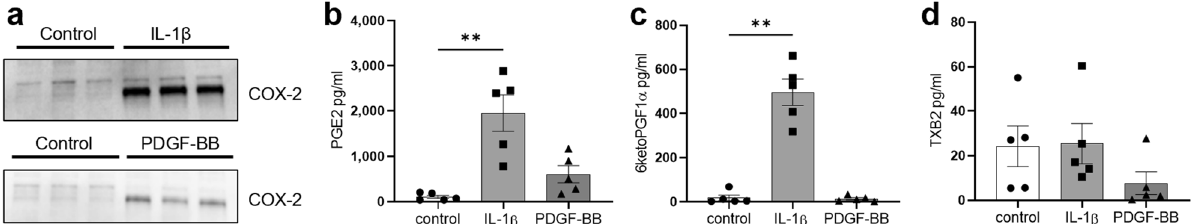
Figure 3. Induction of COX-2 by phosphorylated sphingoid bases and prostaglandins secretion. COX-2 protein levels increased after 24 h stimulation of human mesangial cells with IL-1β or PDGF-BB ( a ). PGE2 is secreted in the medium after both treatments ( b ), while PGI2 (measured through its metabolite 6-keto PGF1α) is secreted after the IL-1β treatment only ( c ). Thromboxane A2 (measured through its metabolite TXB2) secretion is not regulated ( d ). * P < 0.05; ** P < 0.01. Data are reported as mean ± SEM. Uncropped blots after chemiluminescence development and total protein stain free blots are presented in Supplementary Fig. S4c. Quantification of the bands in the western blot is reported in Supplementary Fig. S5.